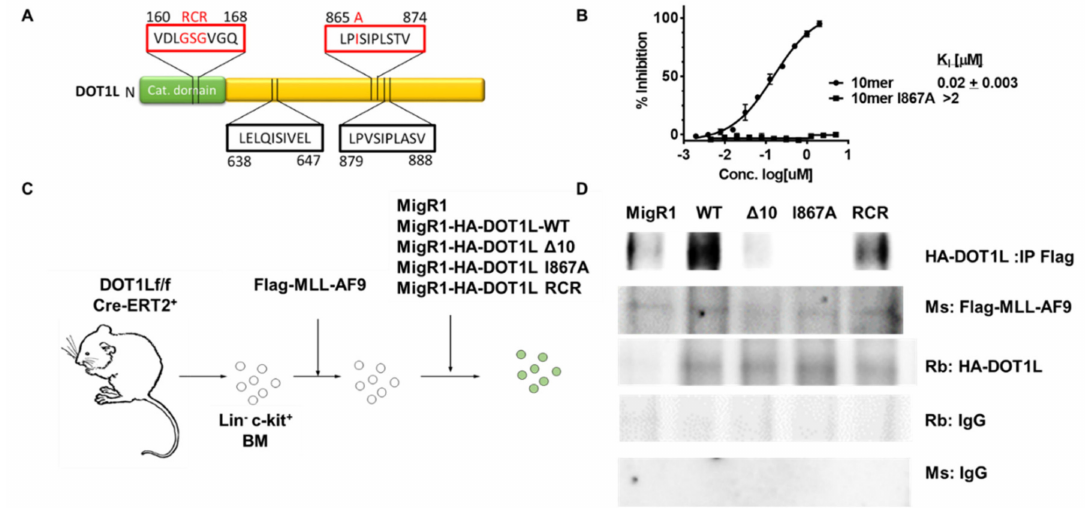
Figure 1. A single amino acid change blocks AF9-DOT1L protein-protein interaction. ( A ) Protein diagram of DOT1L highlighting the catalytic domain mutation from residues 163–165 and AF9 binding domains at residues 638–647, 865–874 and 879–888. The red boxes indicate regions of the protein that were mutated for the following studies. ( B ) Fluorescence Polarization assay showing the that the 10mer peptide from residues 865–874 can compete for binding with AF9 with a fluorescein-labeled DOT1L peptide with a K I of 20 nM; whereas, the peptide with the I867A mutation did not show binding up to 10 µ M. ( C ) Schematic of the process of generating DOT1L f/f MLL-AF9 cell lines with different DOT1L constructs reintroduced. Cells were harvested from the bone marrow of DOT1L f/f CreERT2 mice. The bone marrow was lineage depleted and transduced will MLL-AF9. MLL-AF9 were selected by neomycin treatment then subjected to a secondary transduction with either MigR1 as an empty vector control of one of four DOT1L constructs including, DOT1l-WT, DOT1L- ∆ 10, DOT1L-I867A ( ∆ 10 and I867A mutants block AF9-DOT1L interaction), and DOT1L-RCR (enzymatically inactive DOT1L protein). These cells were then GFP sorted and used for DOT1L excision studies. ( D ) co-Immunoprecipitation (co-IP) using Flag-MLL-AF9 to pulldown HA-DOT1L in the five established murine cell lines showing disruption of the MLL-AF9 and DOT1L protein-protein interaction in the ∆ 10 and I867A mutants cell lines as well as the MigR1 cell line where HA-DOT1L is not present with corresponding Rb (rabbit) and Ms (mouse) IgG